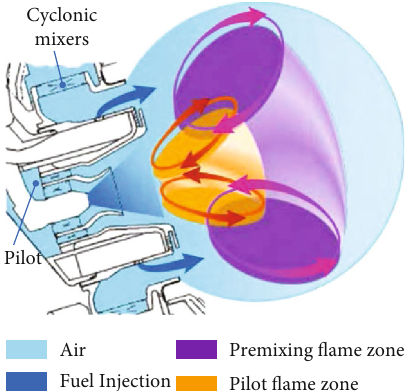
Figure 1: Combustion organization in TAPS [7, 8].